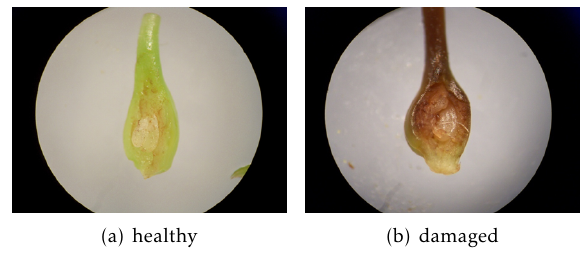
Figure 2. Gynoecium healthy and damaged by frosts. Damage is visualized by brown tissues (extracted from